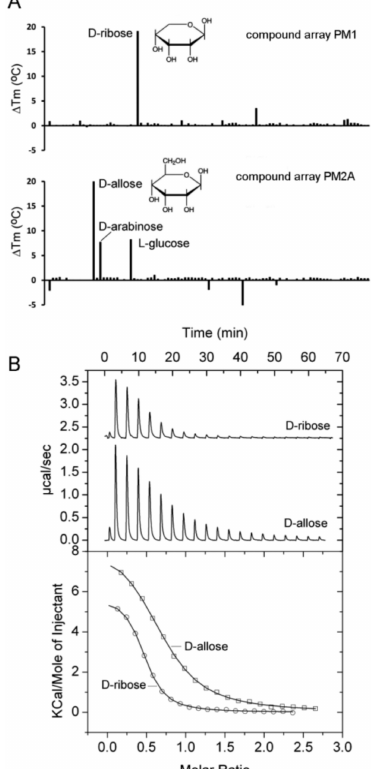
Figure 4. Identification of PA1946 as binding protein for D-ribose and D-allose. ( A ) Thermal shift assays of PA1946 and the compounds of arrays PM1 and PM2A. Shown are T m changes with respect to the ligand-free protein. ( B ) Microcalorimetric titration of 50 µ M PA1946 with 1 mM D-ribose (8 µ L aliquots) and 2 mM d -allose (4.8 µ L aliquots). Upper panel: Raw titration data. Lower panel: Dilution heat corrected and concentration normalized integrated raw data. The line is the best fit using the ‘One Binding Site’ model of the MicroCal version of